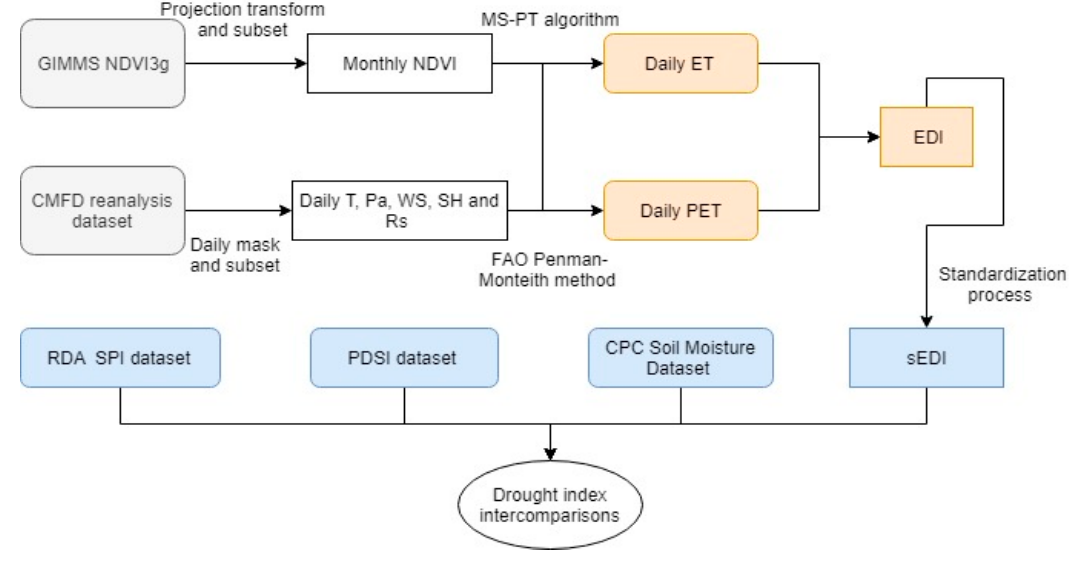
Figure 2. Flowchart of procedure used in this study.